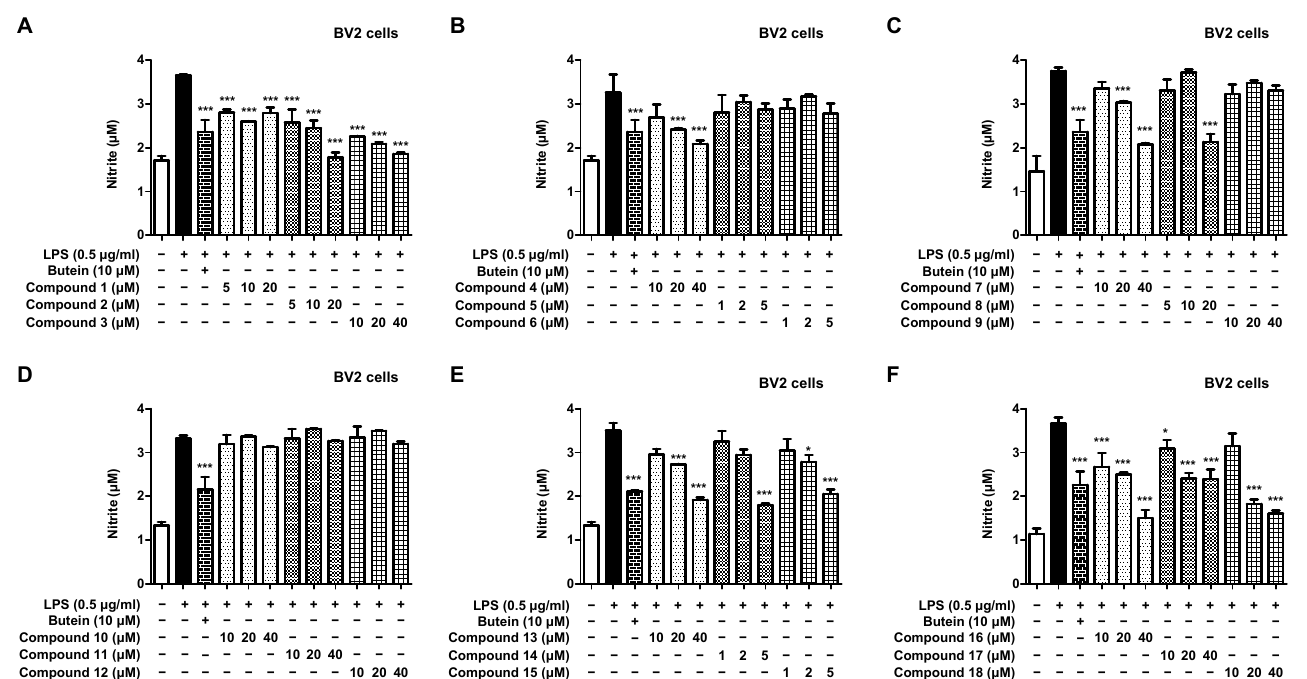
Figure 4. Inhibitory effect of the 18 natural compounds on nitrite production in BV2 microglia cells ( A – F ). The inhibitory effect on nitrite production in BV2 cells was induced for 18 h by pretreatment with the compound at a concentration of 1–40 μ M followed by treatment with lipopolysaccharide (LPS). Data are expressed as the mean ± standard deviation value of three independent experiments. * p < 0.05, *** p < 0.001 vs. LPS.